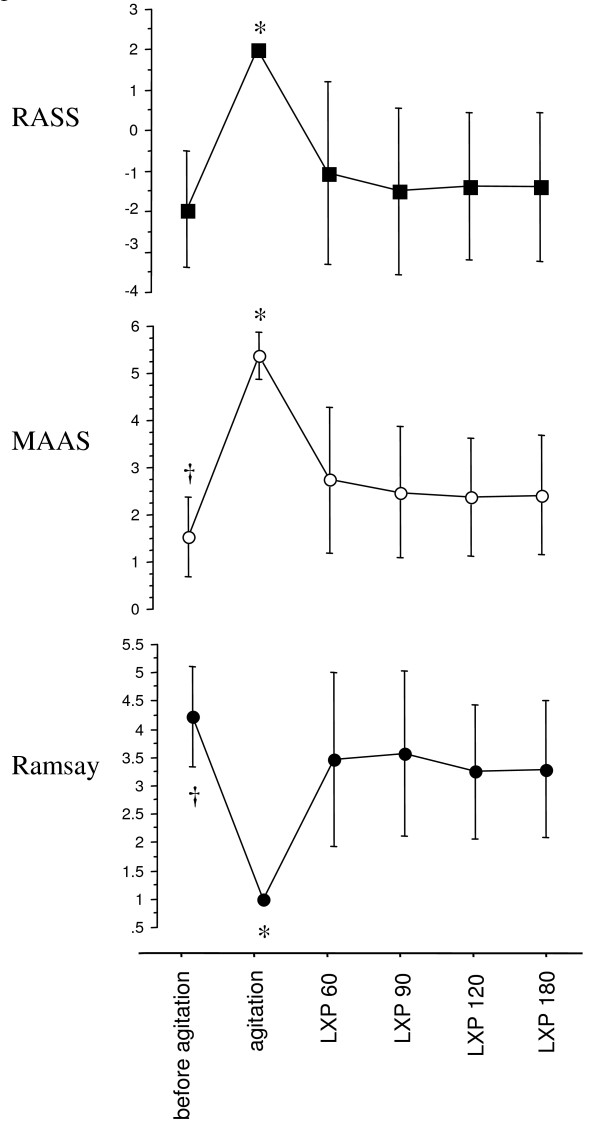
Values for three sedation/agitation scores before agitation, at the time of agitation, and at 60, 90, 120, and 180 minutes after loxapine (LXP) administration. Marked alteration of the three scores was initially observed. Loxapine administration resulted in normalization of the three scores after 1 hour. This normalization persisted for several hours. Significance of differences: *P < 0.0001 versus all other conditions; † P < 0.005 versus all other conditions.